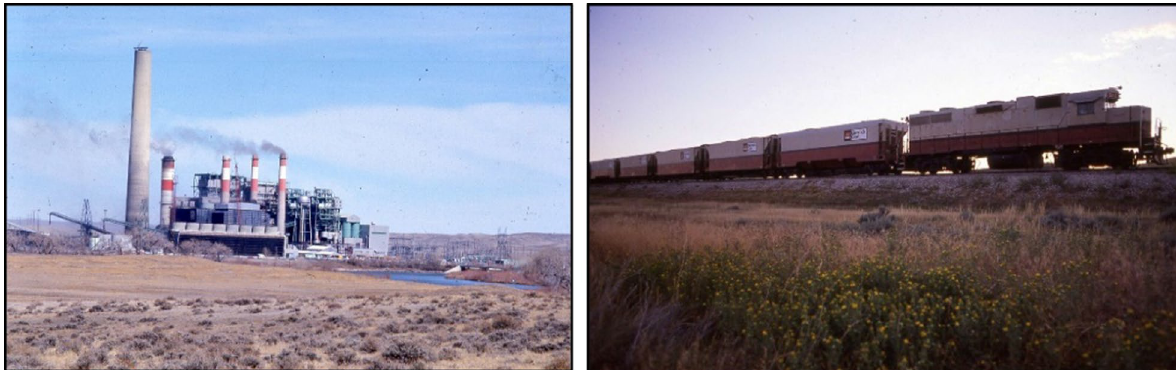
Fig. 1 Case study mine location